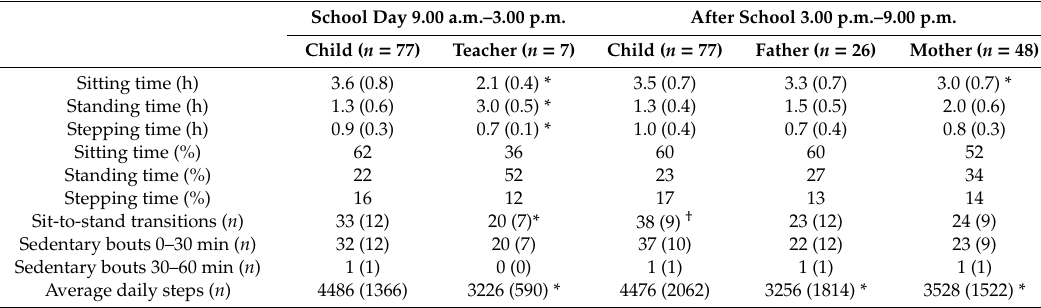
Table 3. Physical activity and sedentary behaviour during and after